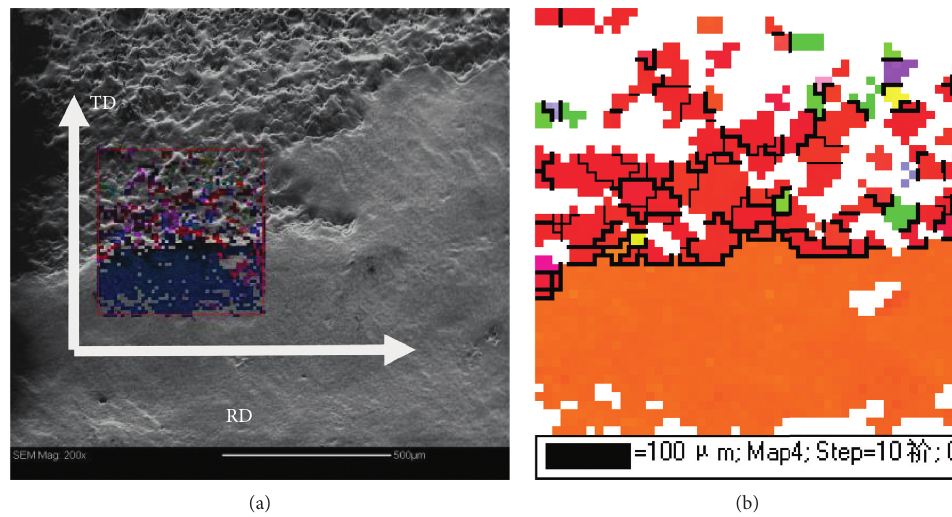
Figure 8: EBSD analyzing of the abnormal grain. (a) Location for EBSD analysis. (b) The results of the EBSD analysis.